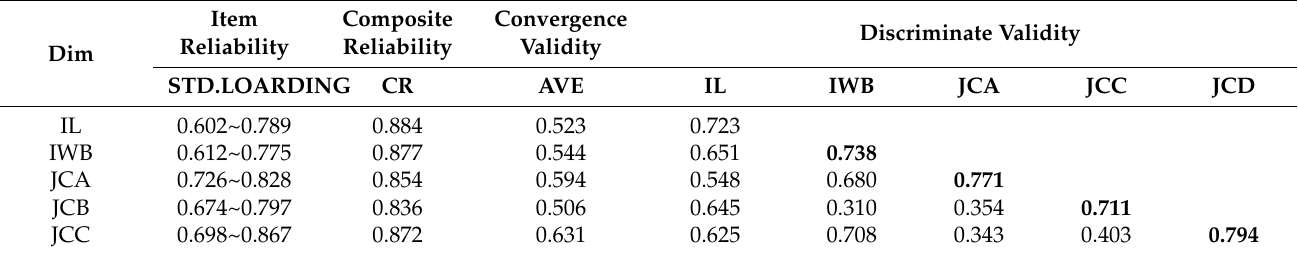
Table 2. Reliability and